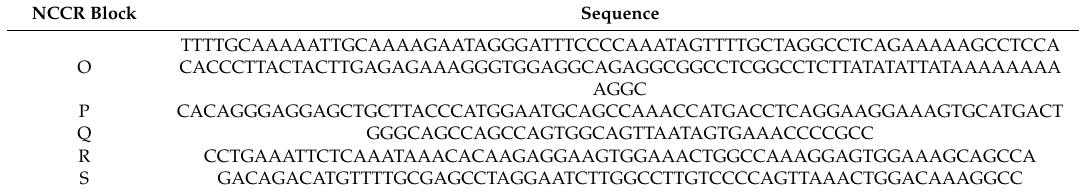
Table 1. The complete sequence of the OPQRS blocks used as archetypes for the BKTyper NCCR